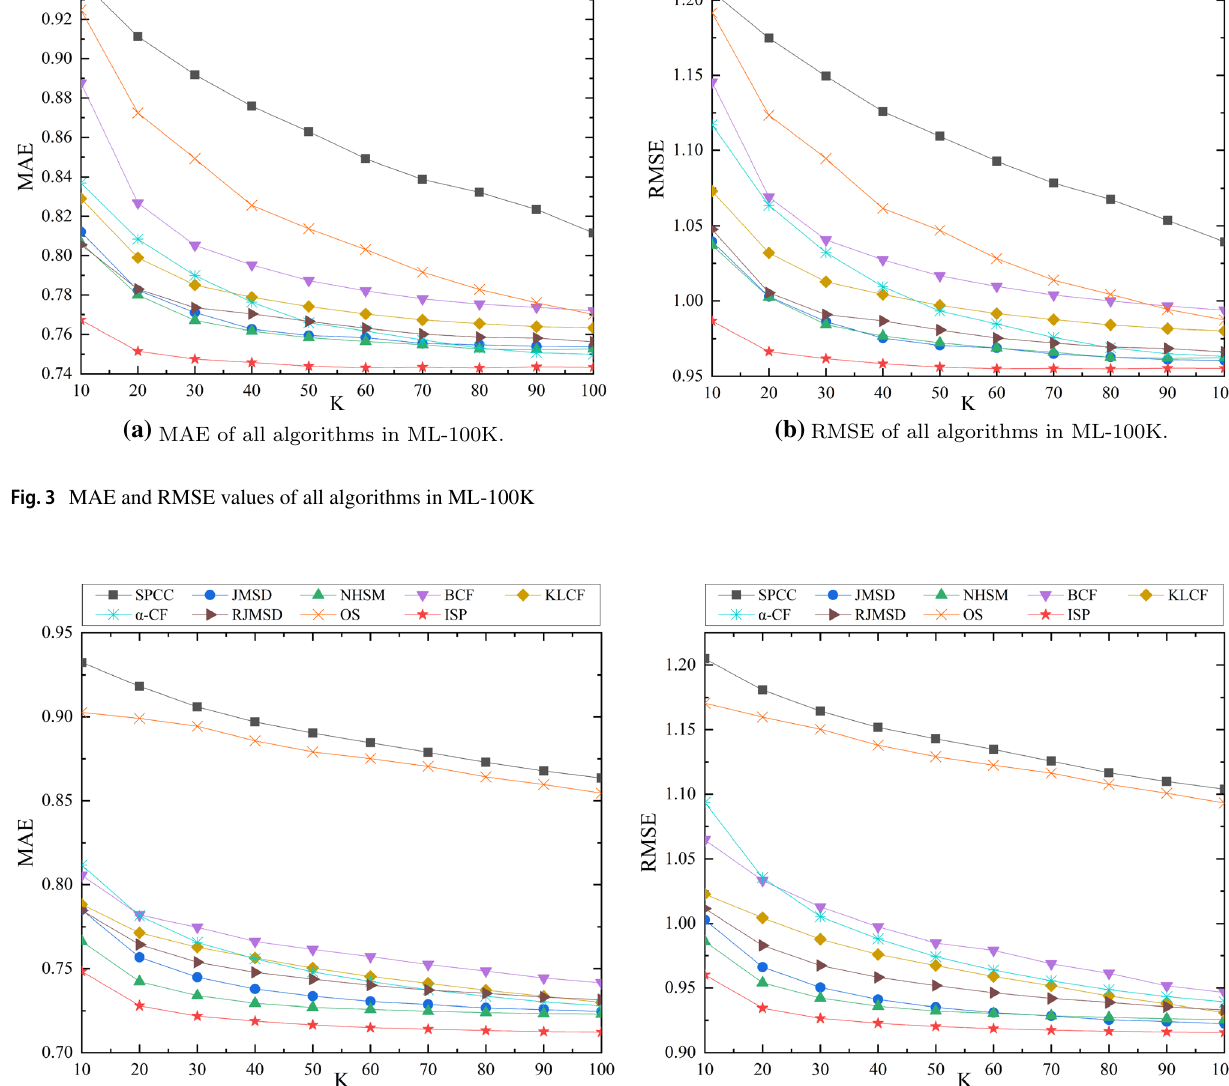
(a) MAE of all algorithms in ML-1M. (b) RMSE of all algorithms in ML-1M. Fig. 4 MAE and RMSE values of all algorithms in ML-1